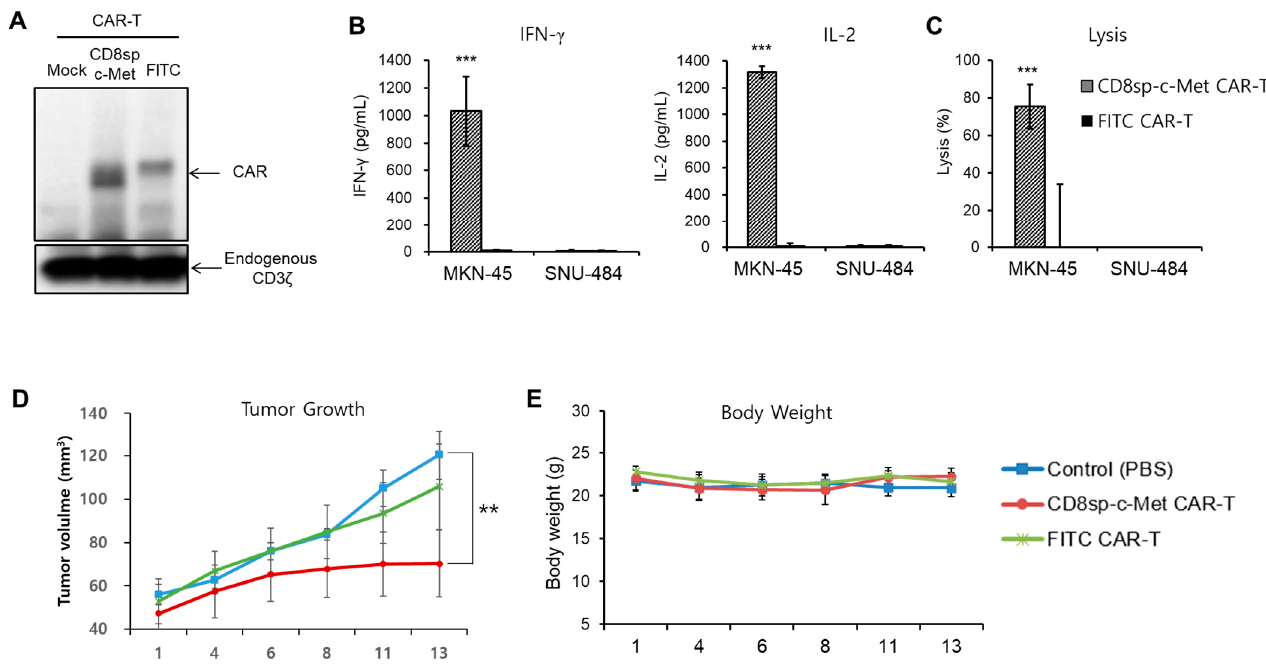
Figure 5. c-Met CAR T cells effectively kill MKN-45 both in vitro and in vivo. T cells were activated with CD3/CD28 Dynabeads and were cultured in medium containing rhIL-7 and rhIL-15. Two days post-activation, T cells were transduced with c-Met CAR or FITC CAR lentivirus. ( A ) At 9 days post-activation, cell lysates were prepared for Western blot to see CAR expression. ( B ) CD8sp-c-Met CAR or FITC CAR T (2 × 10 5 cells) were incubated with MKN-45 or SNU-484 (2 × 10 4 cells). The next day, supernatants were collected to perform IFN- γ and IL-2 ELISA. ( C ) CD8sp-c-Met CAR or FITC CAR T (1.2 × 10 5 cells) were co-incubated with MKN-45 or SNU-484 (1.5 × 10 4 cells) at E:T ratio 8:1 for 20 h. The bars show mean ± S.D. of experiments performed in triplicate. Statistical analysis was performed by the paired t -test. ** p ≤ 0.05; *** p ≤ 0.01, compared with the FITC CAR-T group. ( D – E ) After irradiating 3 Gy to NSG (NOD.Cg-PrkdcscidIl2rgtm1Wjl/SzJ) mice, MKN-45 cells were implanted subcutaneously into the right flank of mice. Nine days after tumor implantation, control (PBS, n = 5), CD8sp-c-Met CAR T ( n = 5), or FITC CAR T ( n = 5) cells were intratumorally administrated. ( D ) Tumor volume and ( E ) weight of mice were assessed at 2–3-day intervals. The bars show mean ± S.E. of the experiment performed in 5 mice. Statistical analysis was performed by one-way ANOVA followed by Dunnett’s multiple comparisons test. ** p ≤ 0.05; *** p ≤ 0.01, compared with the control (PBS) group. (The whole western blots figure see Figure S1).